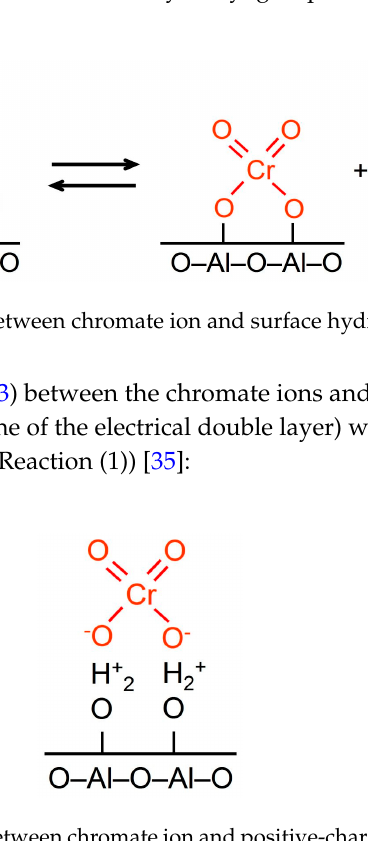
Figure 12. H 2 ‐ temperature programmed reduction (TPR) profiles of